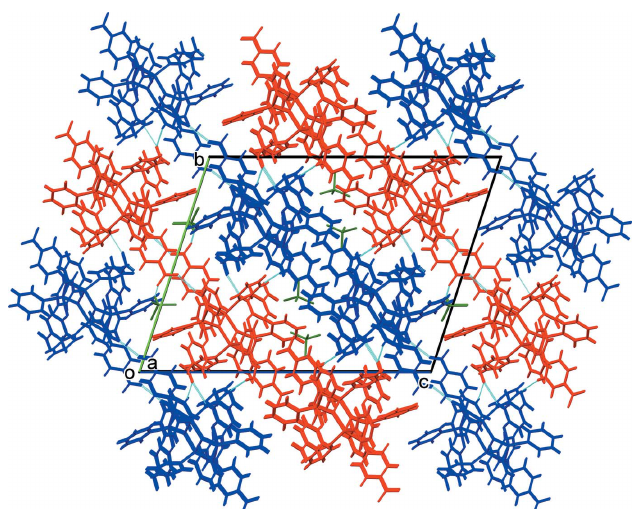
Figure 3 A view along the a axis of the crystal packing of the title compound. The C—H (cid:2)(cid:2)(cid:2) O hydrogen bonds are shown as dashed lines (Table 1). Colour code: A complexes blue, B complexes red, CHCl 3 solvent molecules